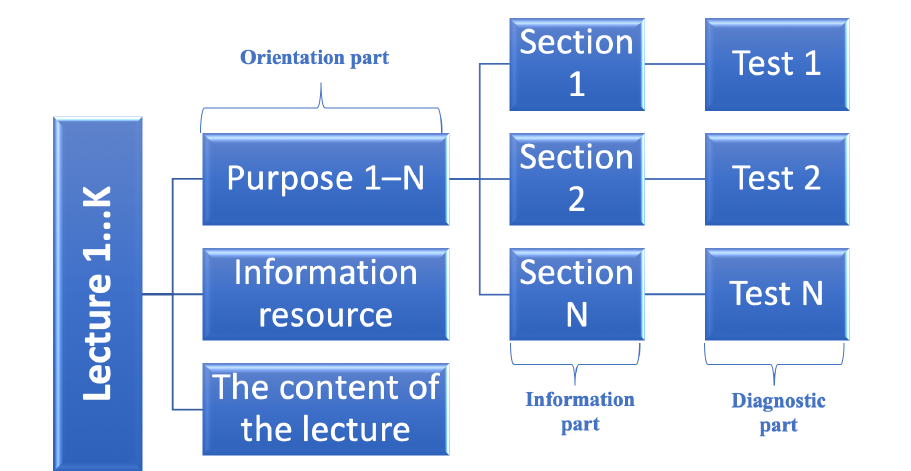
Fig. 2. Generalized structure of lectures of the course «Physical and chemical bases of